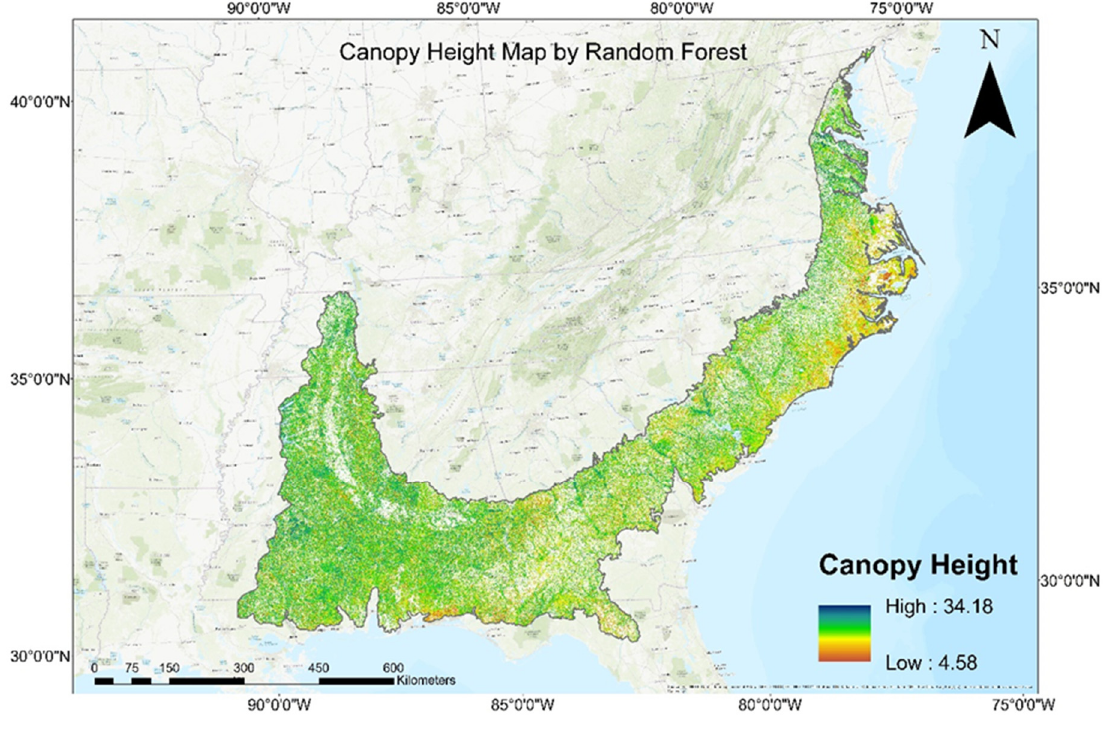
Figure 3. Importance of the predictor variables for estimating canopy height based on random forest.